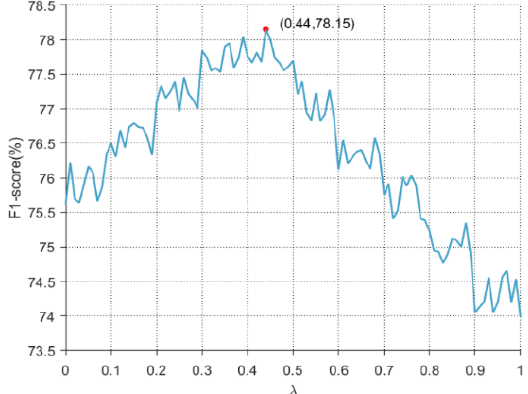
Figure 5. The F1-score of EDWTDA varies with the value of  . Figure 5. The F1‑score of EDWTDA varies with the value of λ